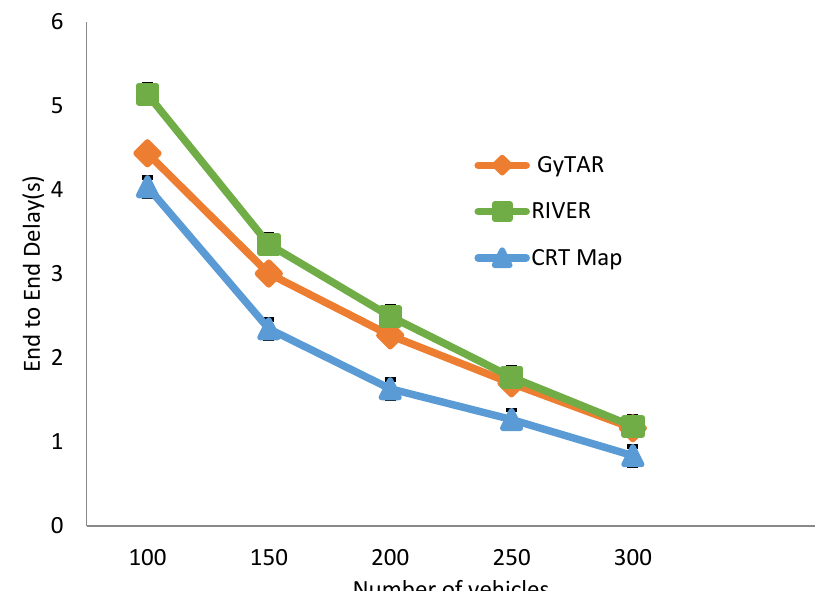
Figure 8. End-to-end delay vs. vehicular density.